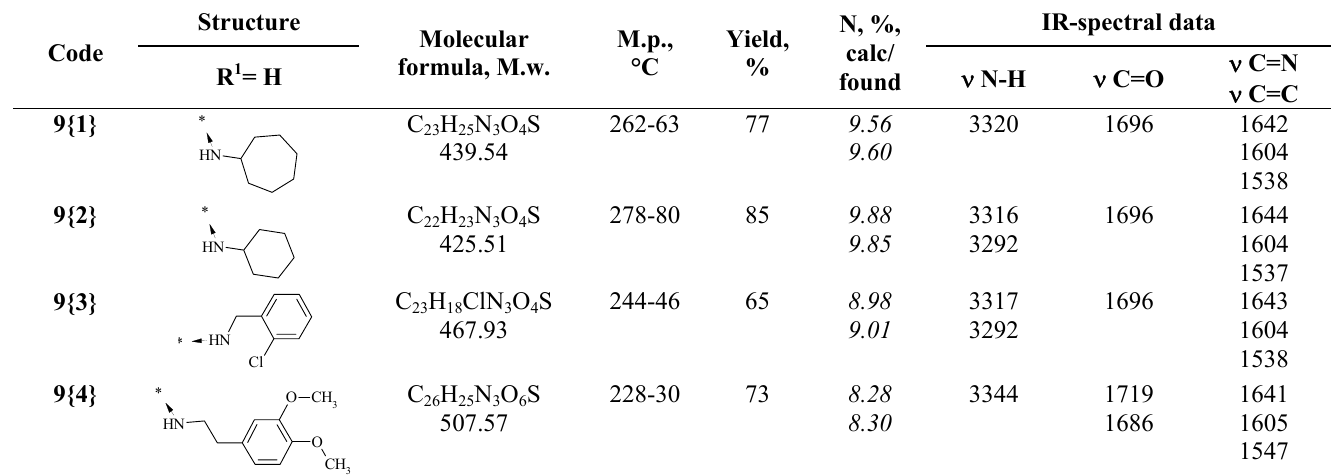
yl]propanoic acids amides Structure IR-spectral data Molecular Code formula, R 1 = H